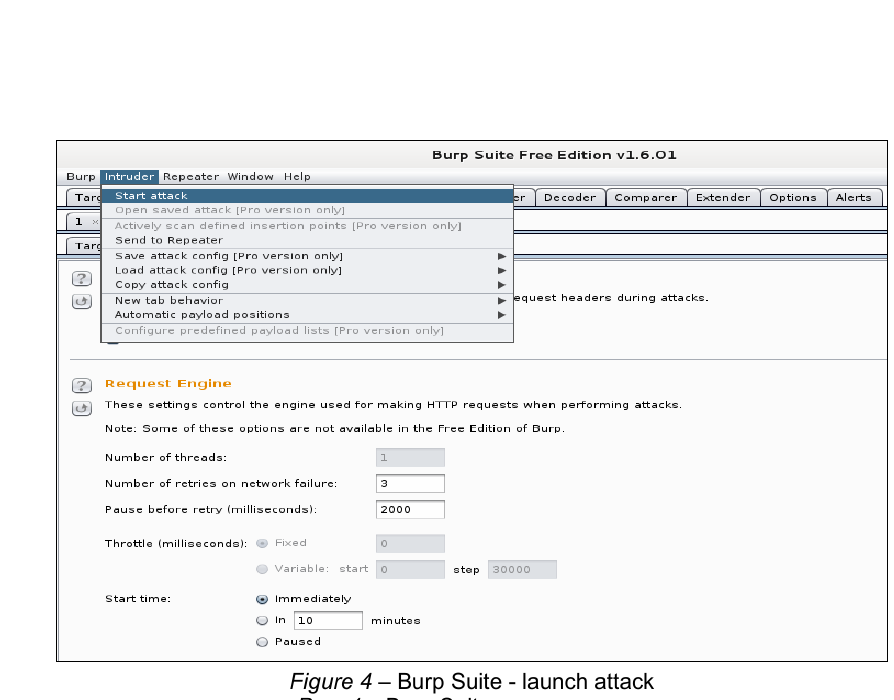
Figure 4 – Burp Suite - launch attack Рис . 4 – Burp Suite – запуск атаки Slika 4 – Burp Suite – realizacija napada